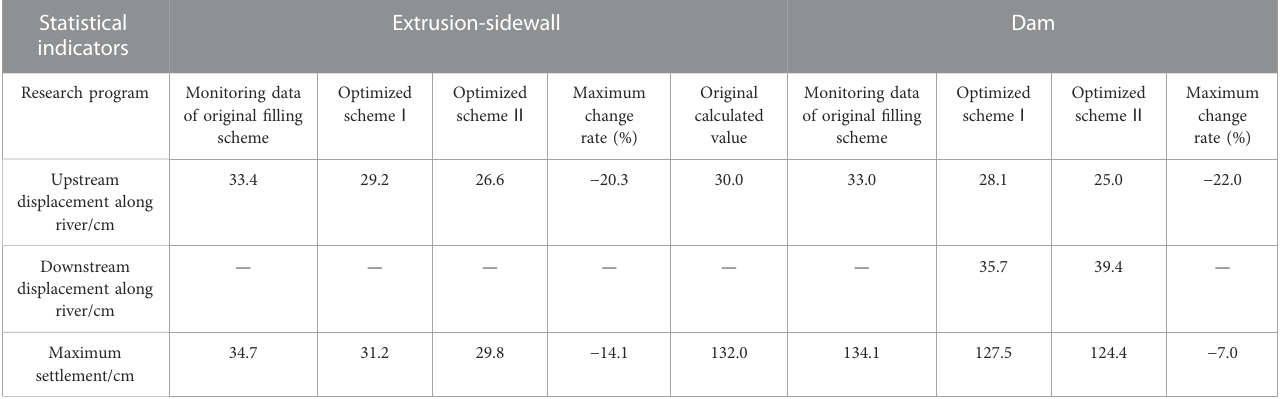
TABLE 3 Compare results of different fi lling the order. Statistical